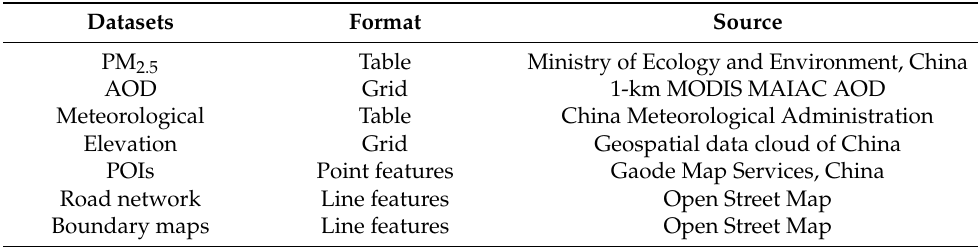
Table 1. Datasets used in this